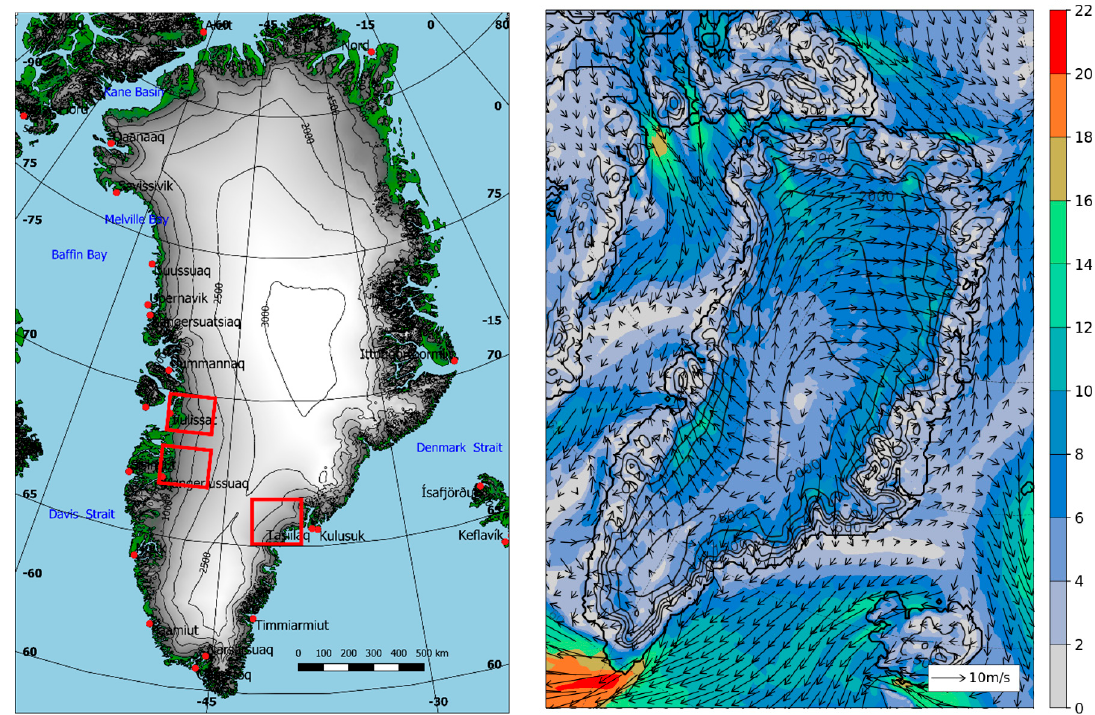
Figure 1. Left : Map of Greenland with topography (isolines every 500 m). The red boxes mark the areas of the KABEG (Katabatic wind and boundary-layer front experiment around Greenland) experiment (shown in detail in Figure 2). Right : Topography (isolines every 500 m), 10 m wind speed (color shaded, in m / s), and 10 m wind vectors (every fifth grid point, scale in the lower right corner) of a CCLM simulation valid at 06:00 UTC 22 April 1997.